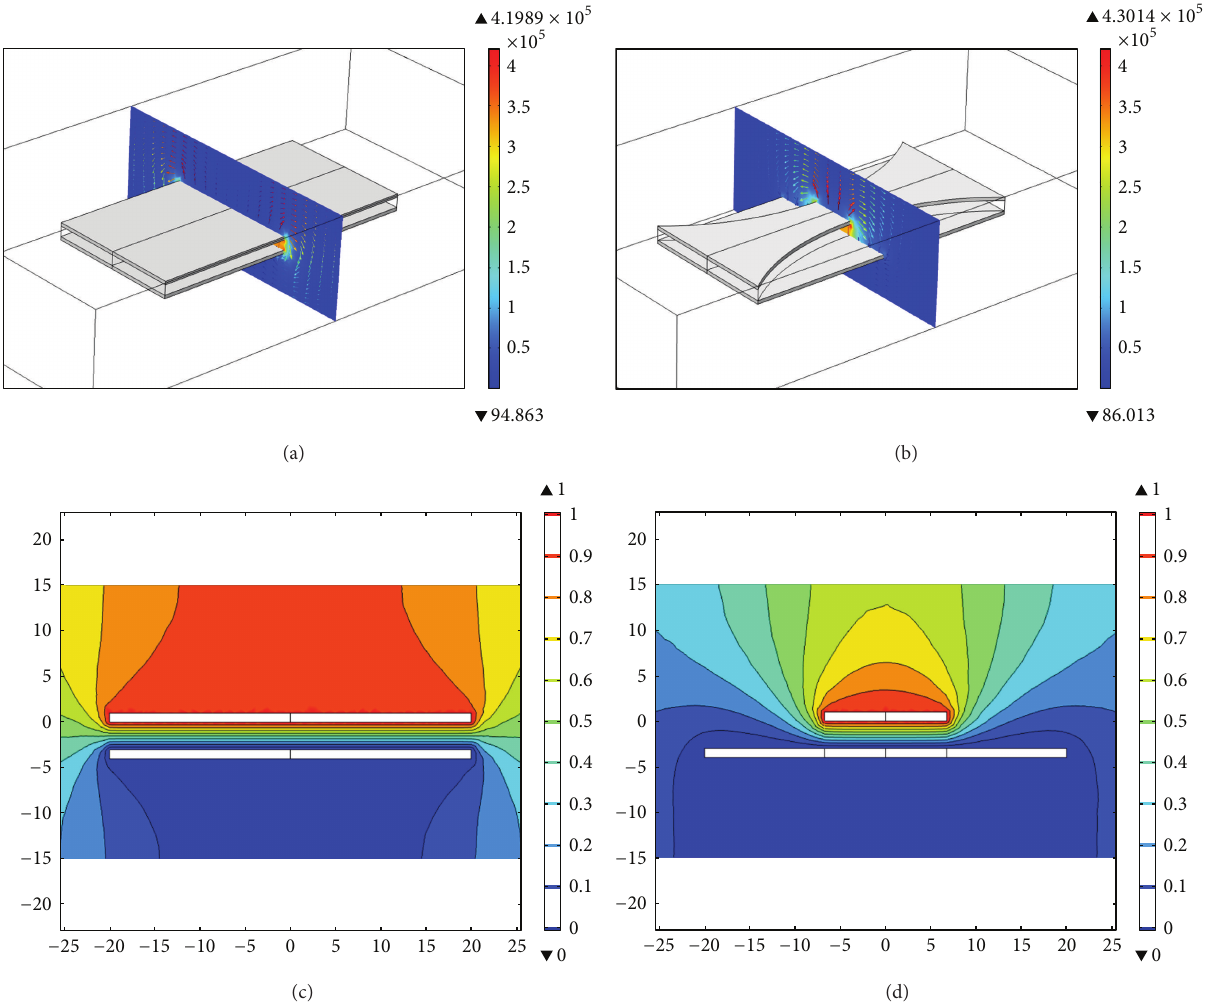
Figure 16: Electric field distribution and the corresponding contour of electric potential: (a) electric field distribution of prismatic beam; (b) electric field distribution of variable geometry microbeam; (c) contour of electric potential of prismatic beam; (d) contour of electric potential of variable geometry microbeam.